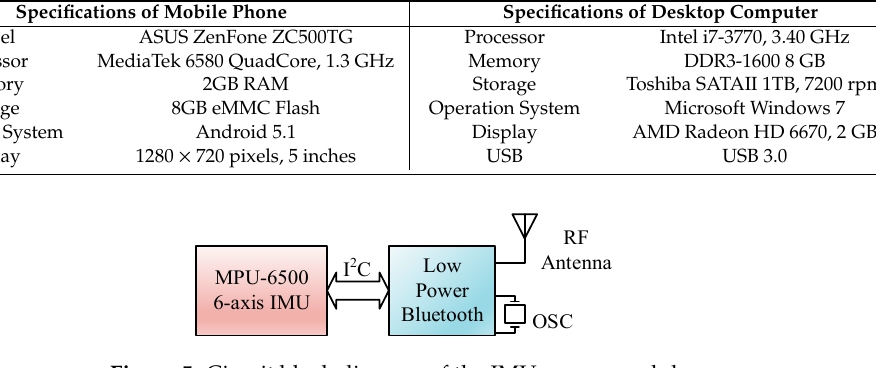
Figure 5. Circuit block diagram of the IMU sensor module.